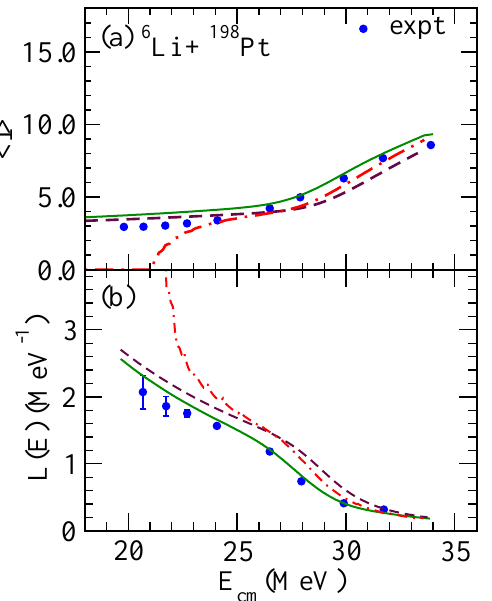
Fig. 2. (color on line) For 6 Li + 198 Pt (a) Average angular mo- mentum and (b) Logarithmic derivative of the fusion excitation function. The results of the coupled-channels calculations using the WS potential (solid line) along with single channel calcula- tions using the WS potential (dashed line) and the M3Y potential with a repulsive core (dot-dashed lines) are shown in panels (a)- (b) (see